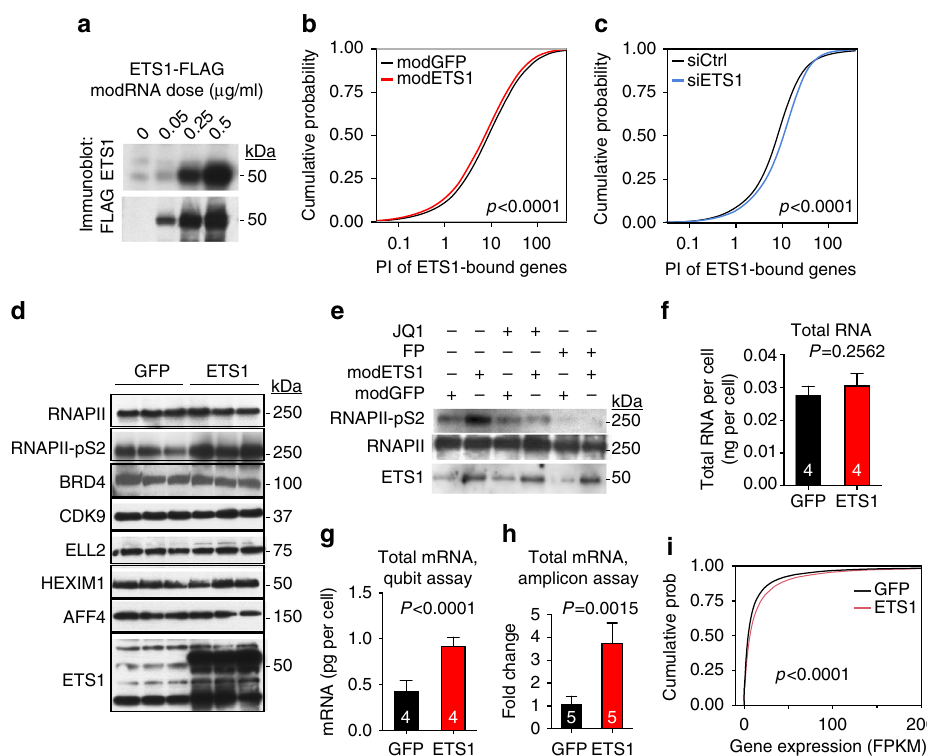
Fig. 2 ETS1 stimulated RNAPII pause release. a Immunoblot of ETS1 expression in HUVEC cells 12 h after transfection by the indicated dose of ETS1 modRNA. b ETS1 overexpression reduced RNAPII pausing at ETS1-bound promoters. HUVEC cells were treated with ETS1 or GFP modRNA. Pausing index (PI) of ETS1-bound genes, a measure of a gene ’ s RNAPII paused at its promoter, was calculated from RNAPII ChIP-seq performed 12 h after transfection. ETS1 shifted the distribution of ETS1-bound genes to lower PI in treatment compared to control. c ETS1 knockdown increased RNAPII pausing at ETS1- bound promoters. Experiment as in b , except that cells were treated with control or ETS1 siRNAs. d ETS1 overexpression using modRNA increased actively elongating RNAPII (RNAPII-pS2) but not total RNAPII. HUVEC cells treated with GFP or ETS1 modRNA were analyzed by immunoblot at 12 h. e